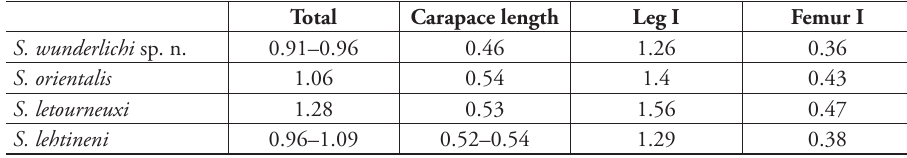
Table 1 . Comparison of size of East Mediterranean Synaphris